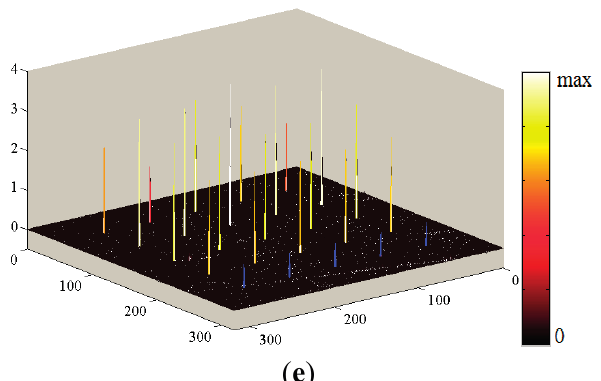
Figure 11. 3-D plots of the detection results for the AVIRIS dataset. ( a ) RX, ( b ) CEM, ( c ) ACE, ( d ) ASMF n = 1, and ( e ) ASMF n = 2.